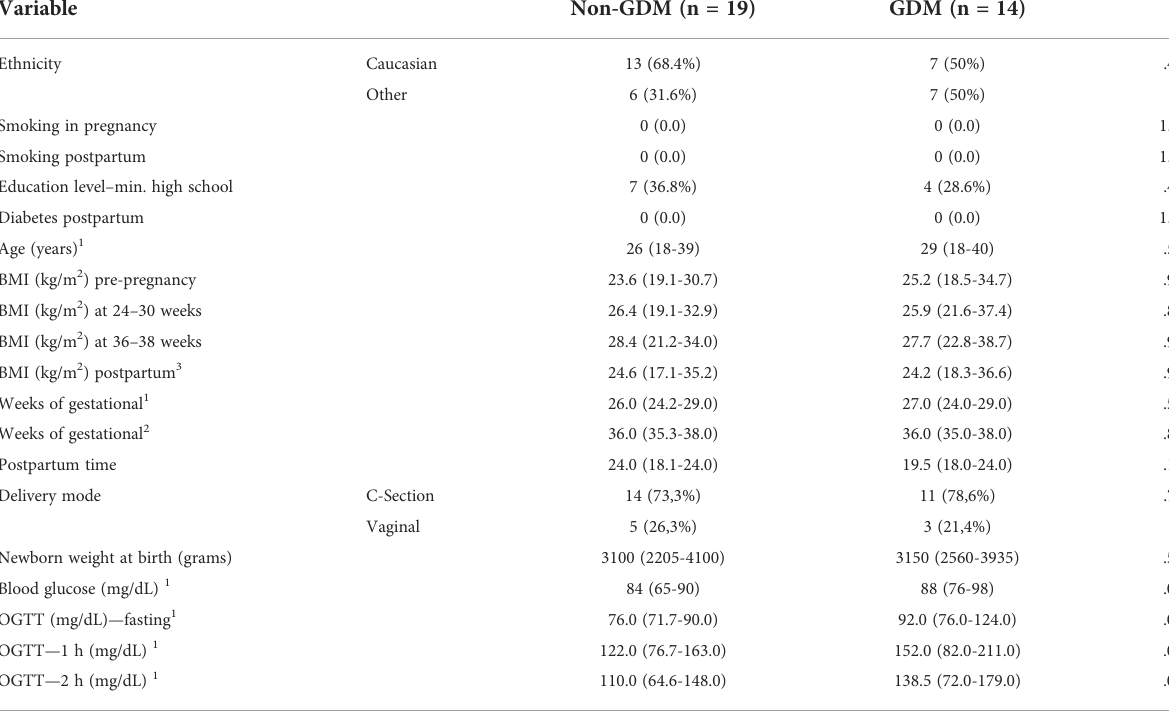
TABLE 1 Average participant characteristics for non-GDM and GDM groups along time